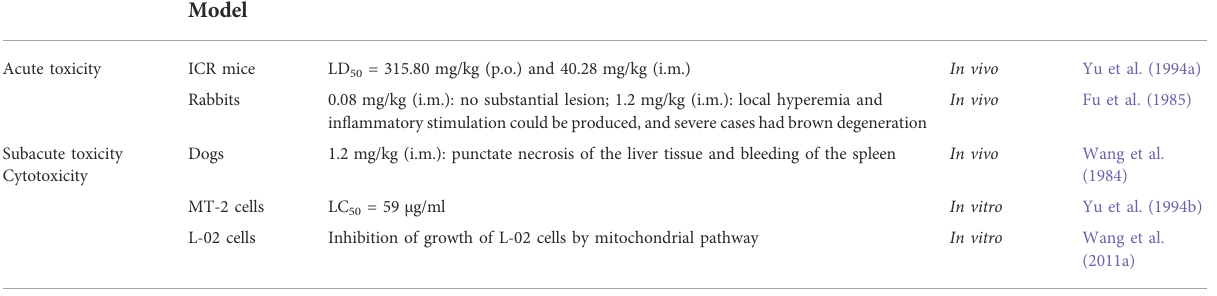
TABLE 5 The toxicity of TBMS-1.